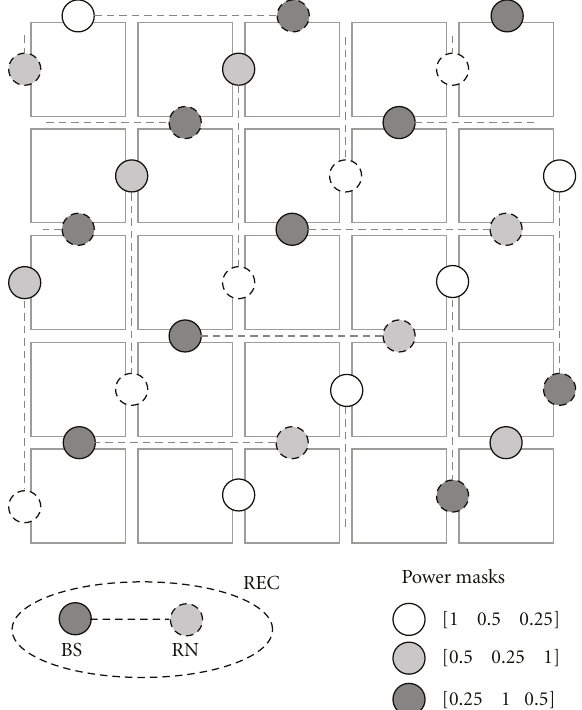
Figure 3: Sketch of metropolitan area cell layout with relay stations and assigned soft-frequency reuse power masks.